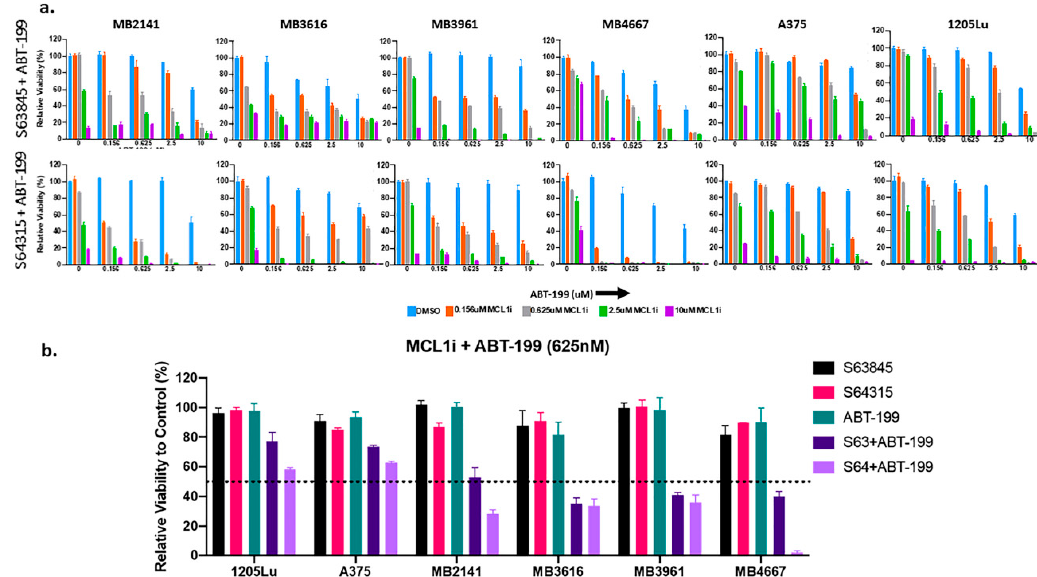
Figure 6. Combination therapy of S64315 / MIK665 (the clinic-ready version of S63845) with ABT-199 has a synergistic e ff ect in treating melanoma samples of diverse genetic backgrounds and is comparable to the e ff ects of S63845 with ABT-199. ( a ) ATP assays of melanoma cell lines upon indicated treatments for 48 h. The viability of the DMSO control for each cell line was set to 100%. Both the combinations (S63845 + ABT-199; upper panel and S64315 + ABT-199, lower panel) had similar e ffi cacy in reducing the cell viability of representative melanoma lines. ( b ) Summary of ATP assay data of six melanoma cell lines, including patient derived cell lines, treated with single drug or a combination of S63845 + ABT-199 or S64315 + ABT-199. All drugs were used at a dose of 625 nM. For visual clarity, the * is not shown in the figures. Both combinations were highly synergistic at sub-micromolar doses. Error bars represent +/ − SEM. For clarity and readability, we listed p values in Table S6.